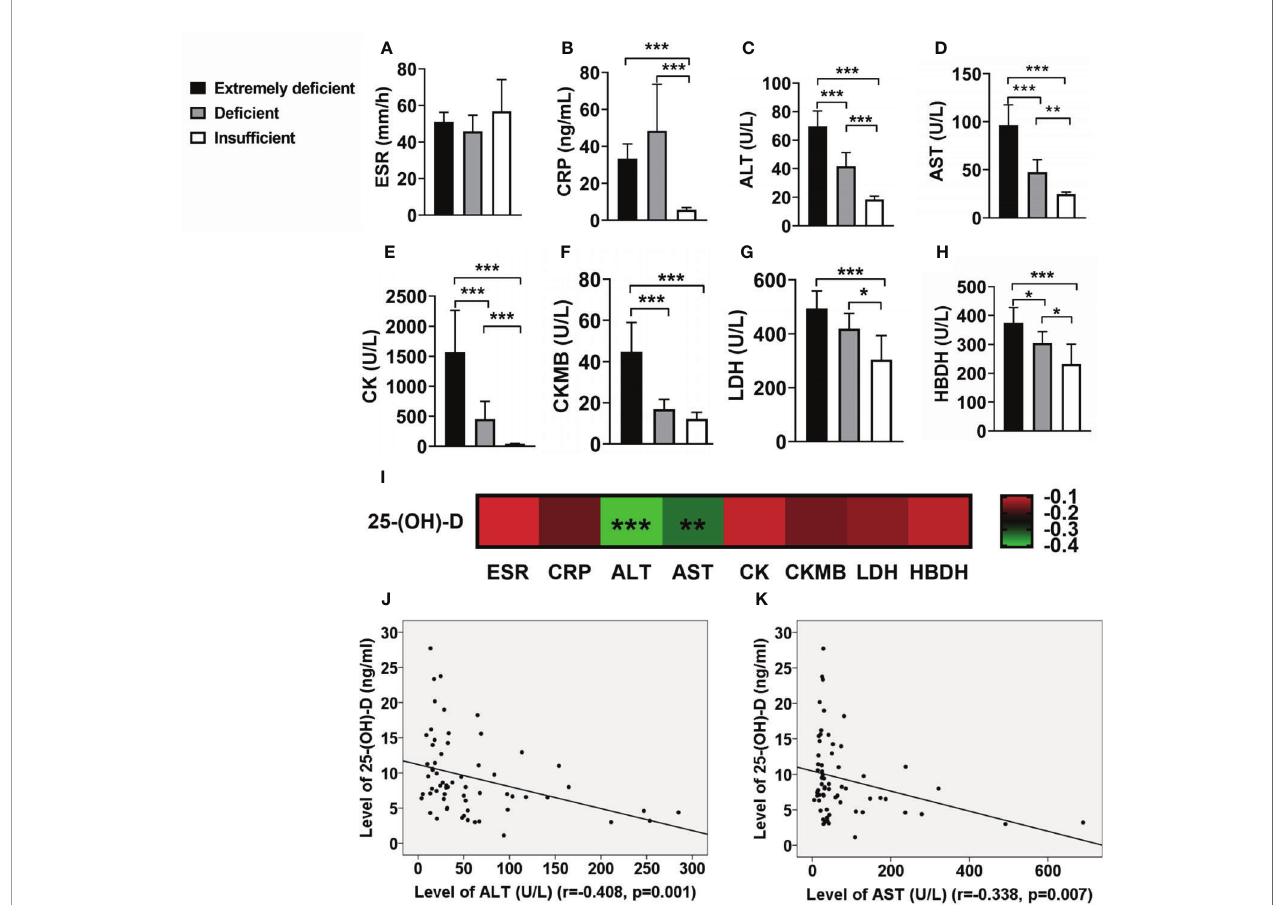
FIGURE 2 | The associations of vitamin D levels with in fl ammatory biomarkers in IIM patients. (A) ESR has no signi fi cant correlation with vitamin D. (B) The level of CRP in patients with de fi cient vitamin D were signi fi cantly higher than those of patients with insuf fi cient vitamin D. (C – H) As the degree of vitamin D de fi ciency increased, the levels of serum muscle enzymes elevated. (I) The associations of 25-(OH)-D levels with in fl ammatory biomarkers in IIM patients. (J, K) The serum 25-(OH)-D levels were negative correlated with ALT and AST. *p < 0.05, **p < 0.01, ***p <